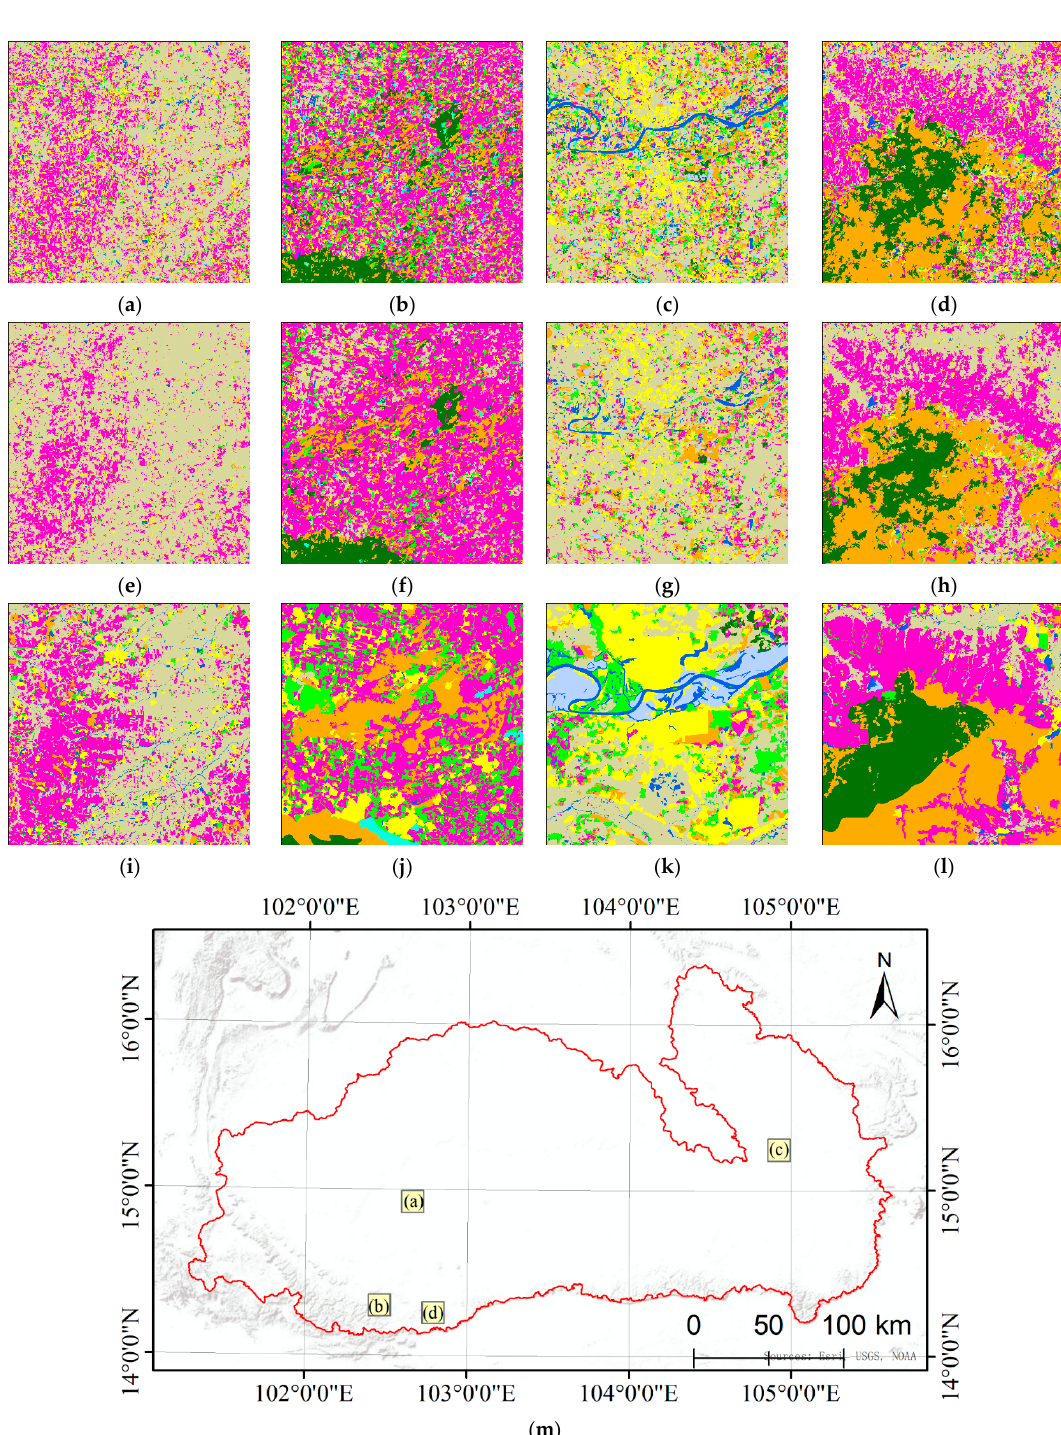
Figure 7. Details of the pre-classification land cover map versus the decision fusion land cover map. Four locations mainly containing paddy rice, dryland, developed land, and forests are shown at a larger scale: ( a ) mainly paddy rice, dry land, and developed land; ( b ) mainly dryland and forest; ( c ) mainly paddy rice, water, and developed land; ( d ) mainly dryland and forest; ( e – h ) the same regions with decision fusion results; ( i – l ) the same regions with manually interpreted land cover. ( m ) is the location of the four regions.